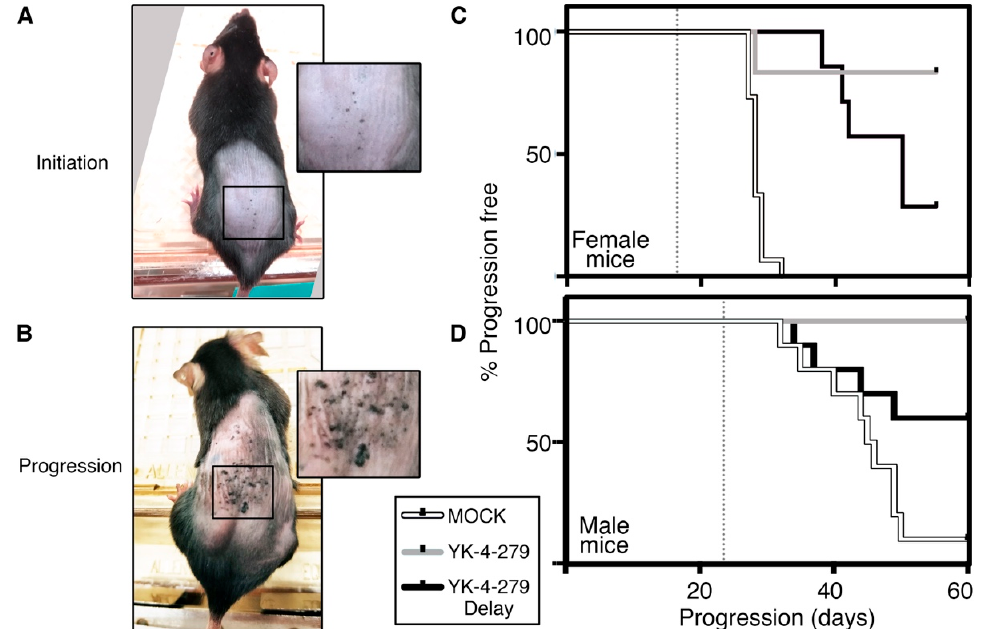
Figure 2. YK-4-279 inhibits melanoma progression in a mouse model of melanoma. ( A , B ) Gross morphology of mice with initiation ( A ) and progression ( B ) lesions. Boxed area indicated is magnified 200% in insets. ( C , D ) Kaplan–Meier progression free survival graphs of female ( C ) and male ( D ) mice. Groups on each graph are indicated as MOCK groups (white line), YK-4-279 groups (grey lines), and YK-4-279 delay groups (black lines). Dotted grey lines mark the average (median) days for tumor initiation for female and male MOCK groups. Both male and female YK-4-279 and YK-4-279 delay groups are significantly different from MOCK groups ( p < 0.0001 male and female YK-4-279 groups and female mock delay, p = 0.047 male YK-4-279 delay). Mouse numbers for MOCK, YK-4-279, and YK-4-279 delay were n = 15, 12, and 7 (females) and n = 10, 11, and 10 (males), respectively. The study has at least 85% power for each comparison of the two YK-4-279 groups to sex matched MOCK controls.